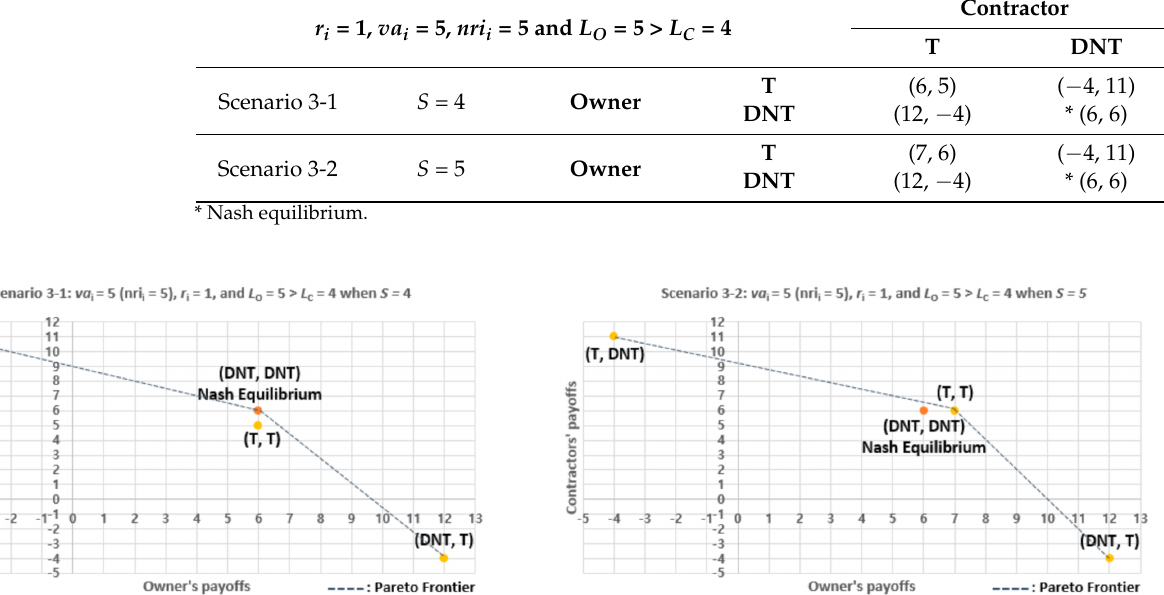
Figure 3. Nash equilibrium and Pareto frontier in Scenario